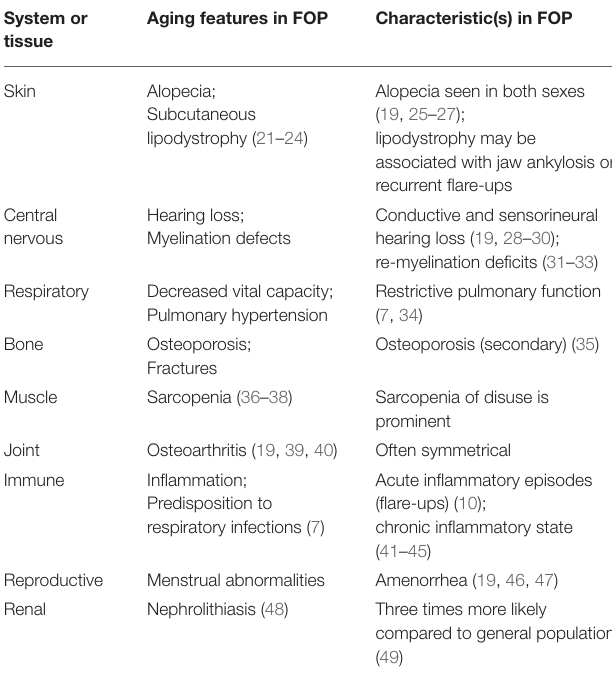
TABLE 2 | Progeroid features in